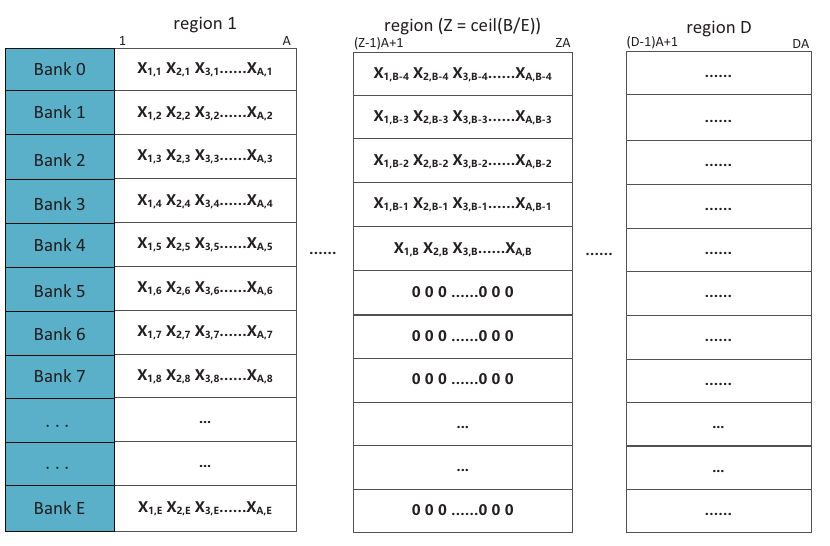
Figure 3. The way of storing the source